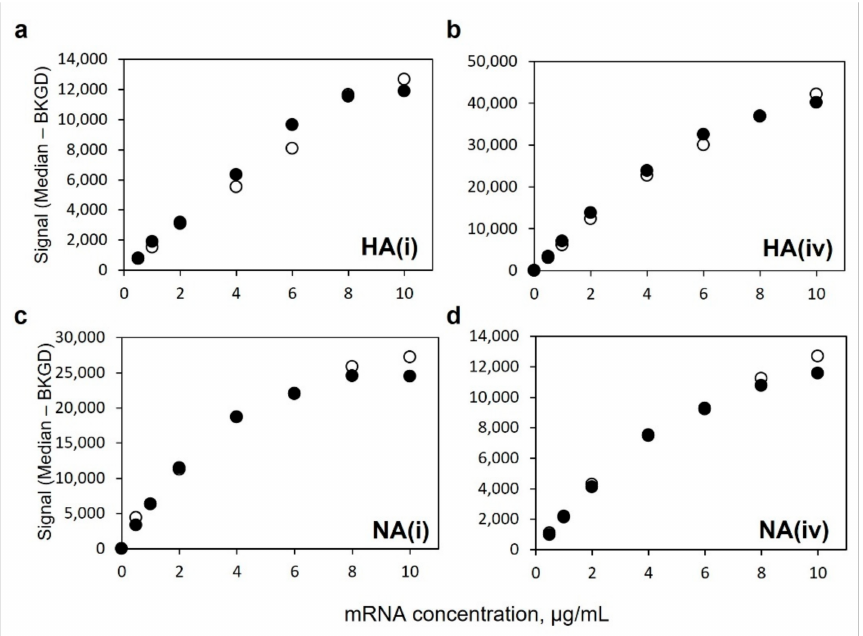
Figure 4. Similarity of response for monovalent ( • ) and bivalent ( polyT oligo detection label for HA mRNA using ( a ) HA(i) coding region capture, ( b ) HA(iv) coding region capture, and for NA mRNA using ( c ) NA(i) coding region capture, and ( d ) NA(iv) coding region